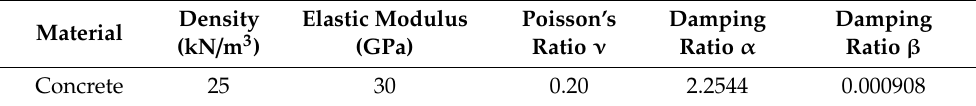
Table 3. Properties of the concrete used in the tunnel lining.